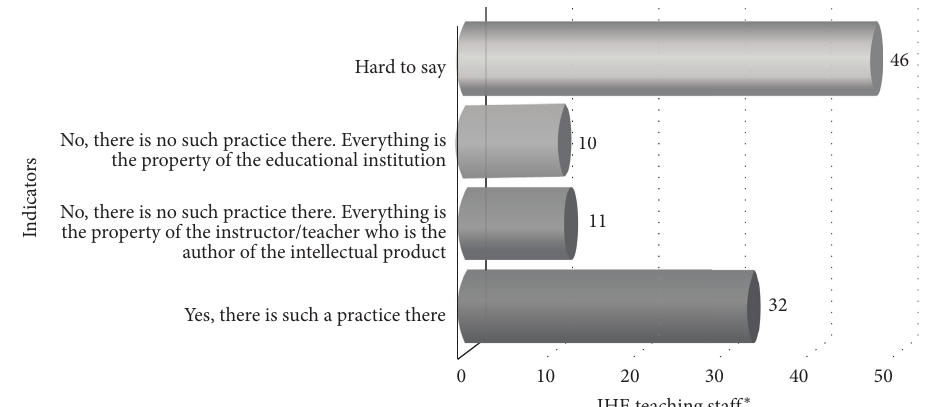
Figure 3: Practices of copyright agreements on intellectual products. ∗ The percent can be less than 100 % because the “other” answers are not